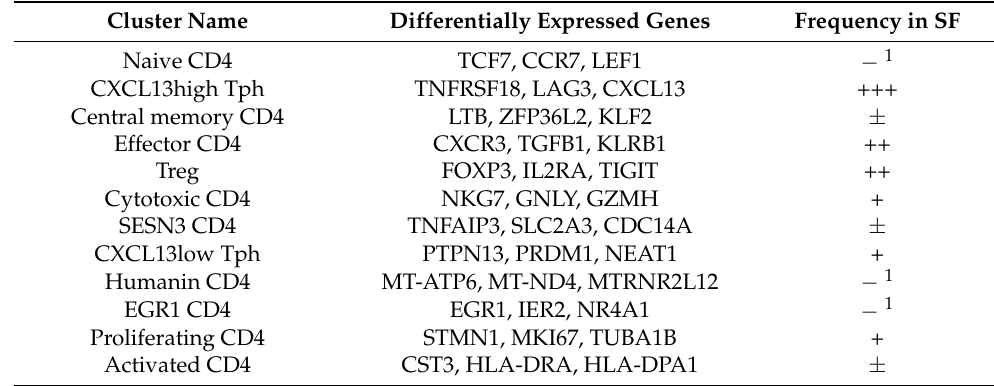
Table 2. CD4 T-cell clusters in RA joints reported by Argyriou et al.